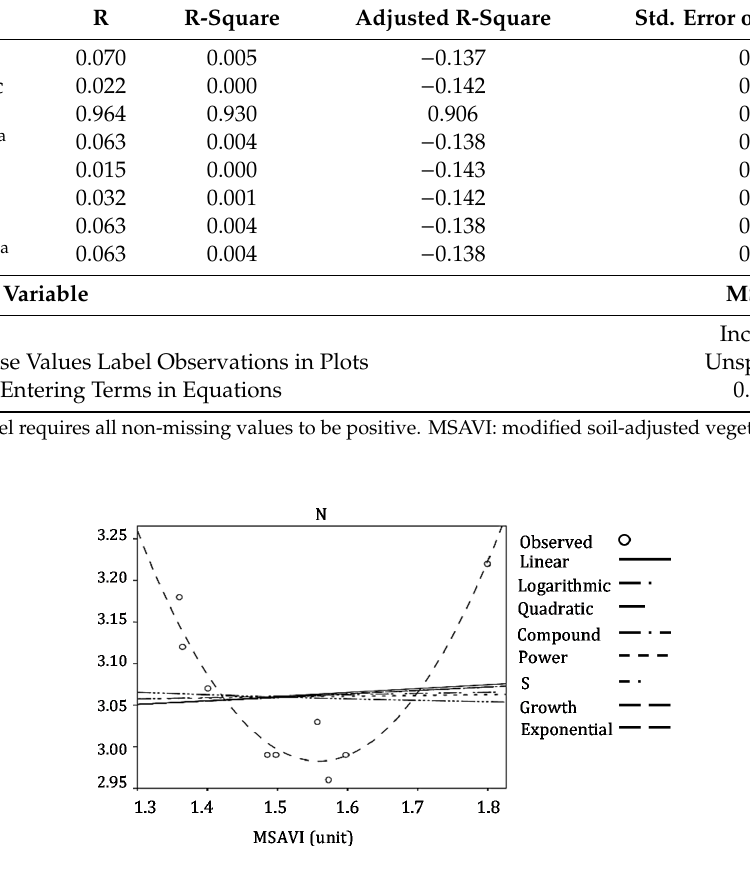
Figure 6. Result of curve-fitting for MSAVI. MSAVI: modified soil-adjusted vegetation index .